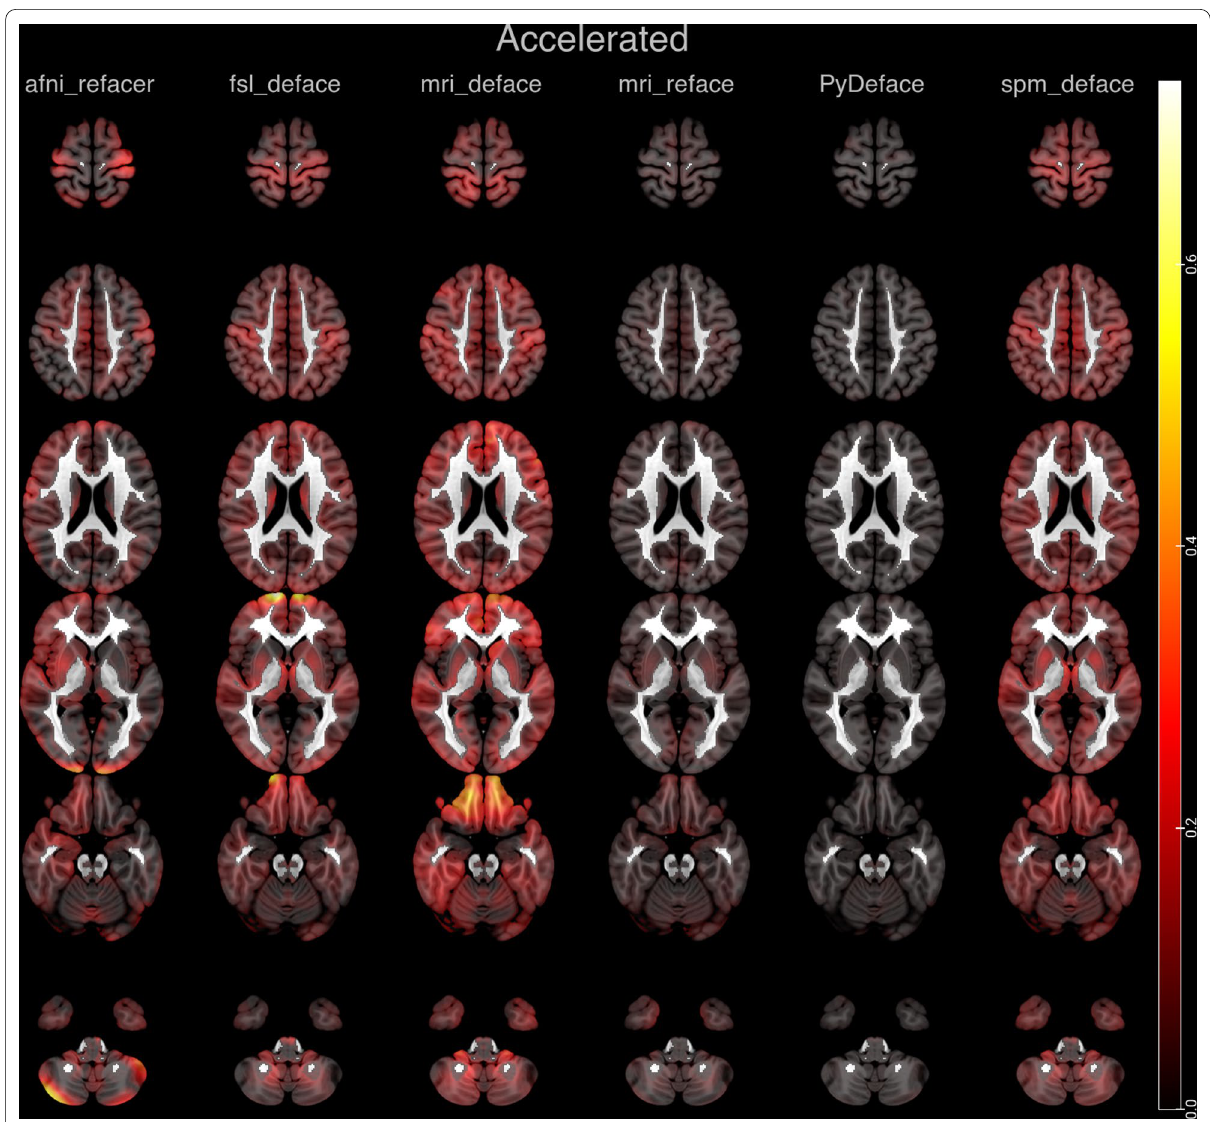
Fig. 4 Absolute mean differences of the z-scores plotted as a heat map onto representative axial slices of the SPM152 standard template after applying the different defacing approaches on accelerated